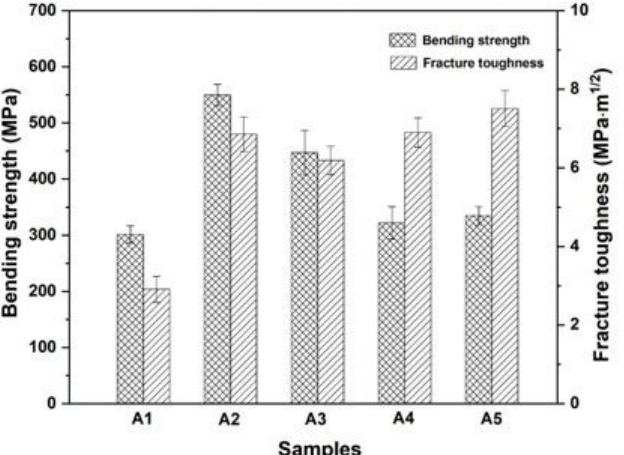
Figure 1. Mechanical properties of the samples.